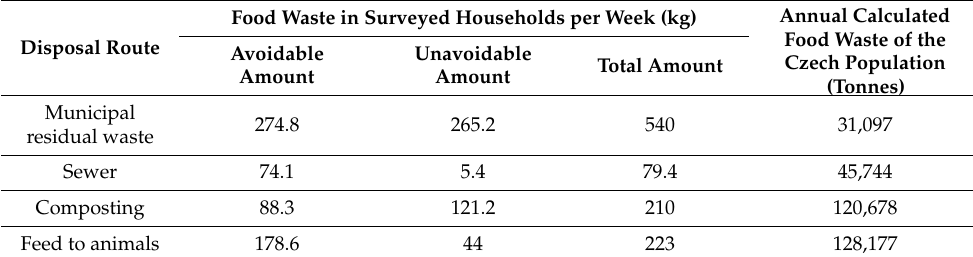
Table 6. Quantity of food waste by all household members per week by a disposal route.